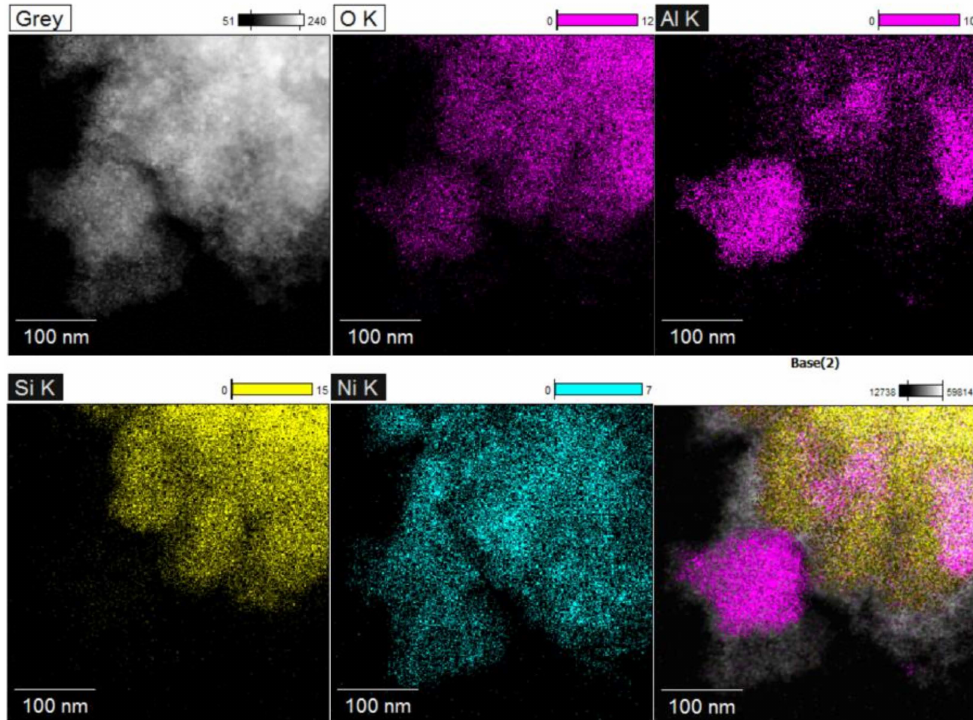
Figure 7. The mapping of Ni@C/Z5+Al.